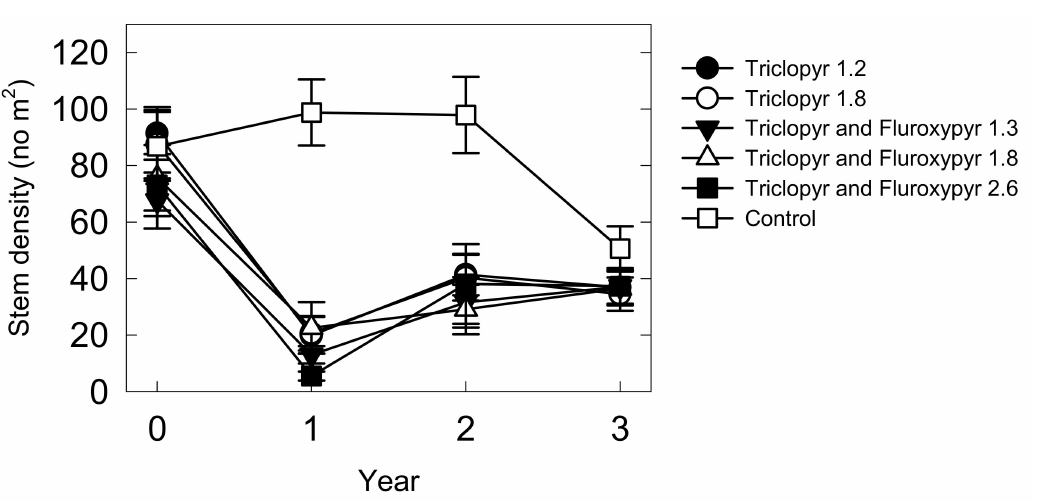
Figure 1. Stem density ± standard error bars of Lespedeza cuneata over three years following herbicide treatments (year zero) or in untreated control plots across three prairie restoration sites. Stem density was significantly higher ( p < 0.05) in control versus herbicide treatments (see Table 3 for details) in years 1 and 2 but not in years 0 or 3. In year 1, stem density in triclopyr 1.2, triclopyr 1.8, and triclopyr